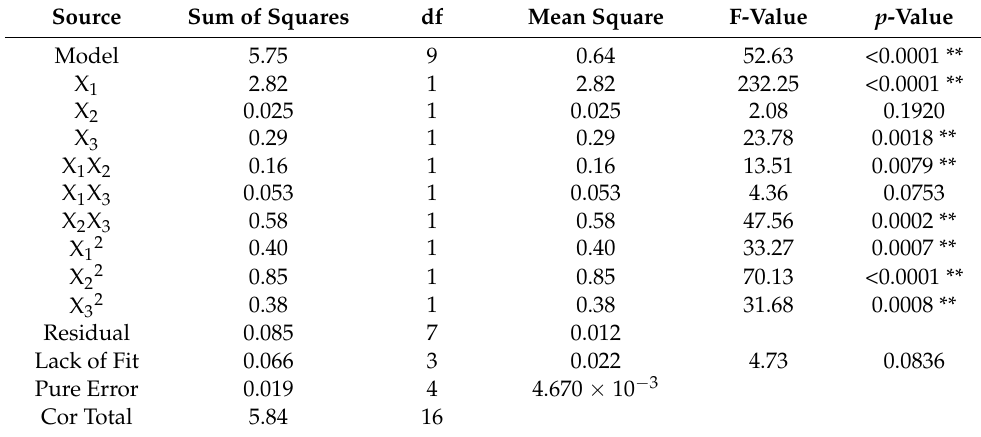
Table 2. Variance analysis results of the regression